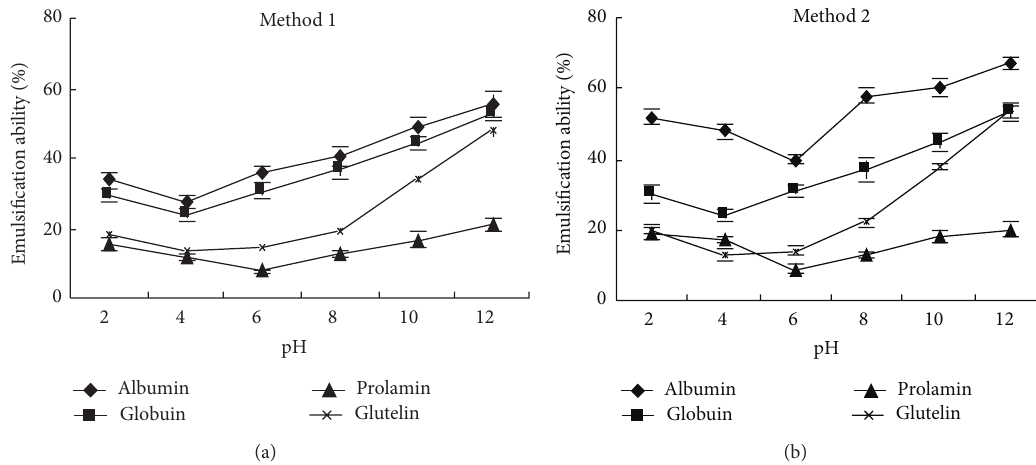
Figure 3: Emulsion activity index at different pH levels of FRBPs prepared by the two extraction